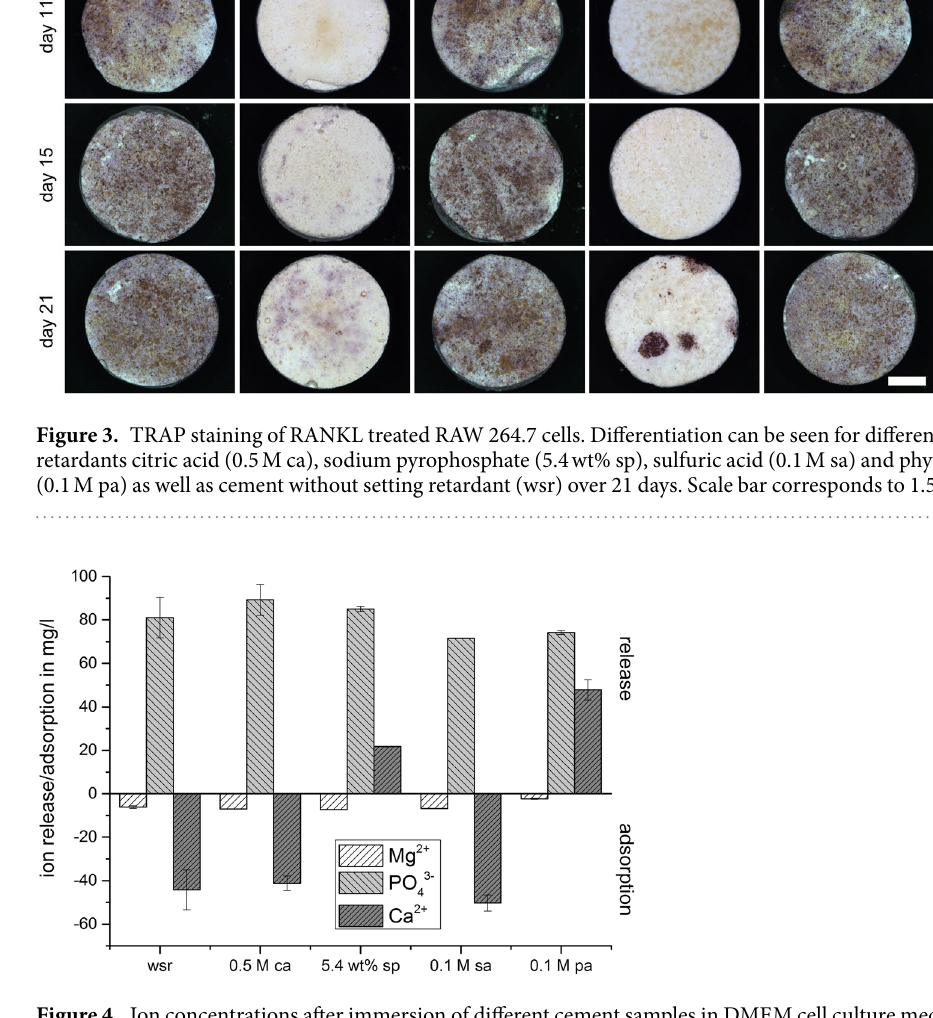
Figure 4. Ion concentrations after immersion of different cement samples in DMEM cell culture medium for 24 h at 37 °C in relation to fresh medium. Samples were prepared without setting retardant (wsr) and retardants citric acid (0.5 M ca), sodium pyrophosphate (5.4 wt% sp), sulfuric acid (0.1 M sa) and phytic acid (0.1 M